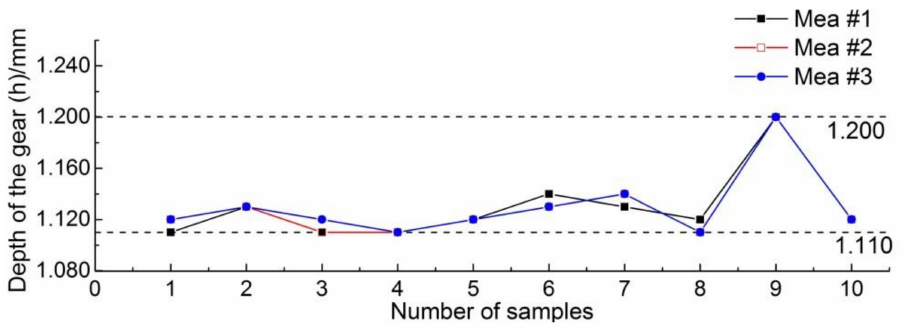
Figure 11. The depth of the 10 gears measured by the second operator (three measurements for each sample).